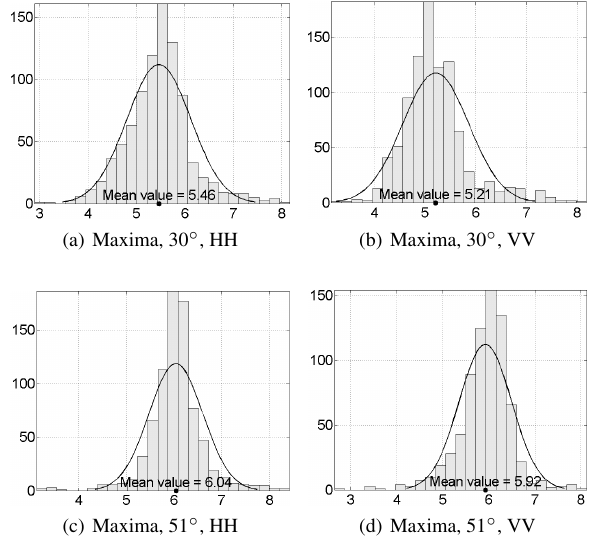
Figure 5. Alexanderplatz, intensity distribution of layover pixels for different polarizations and incidence angles.